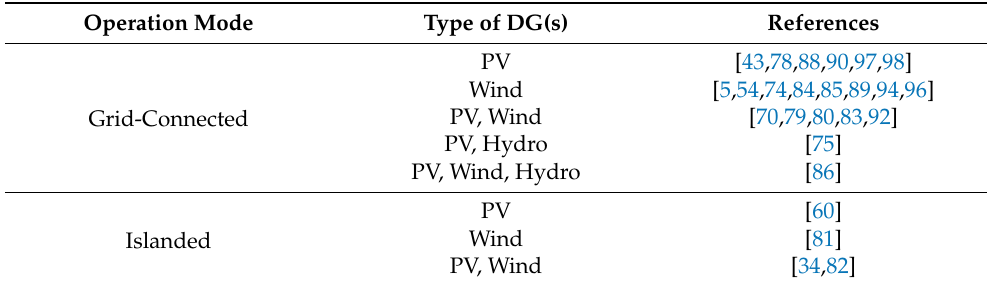
Table 2. Summary of simulation tools in different operation modes with various DGs. Operation Mode Type of